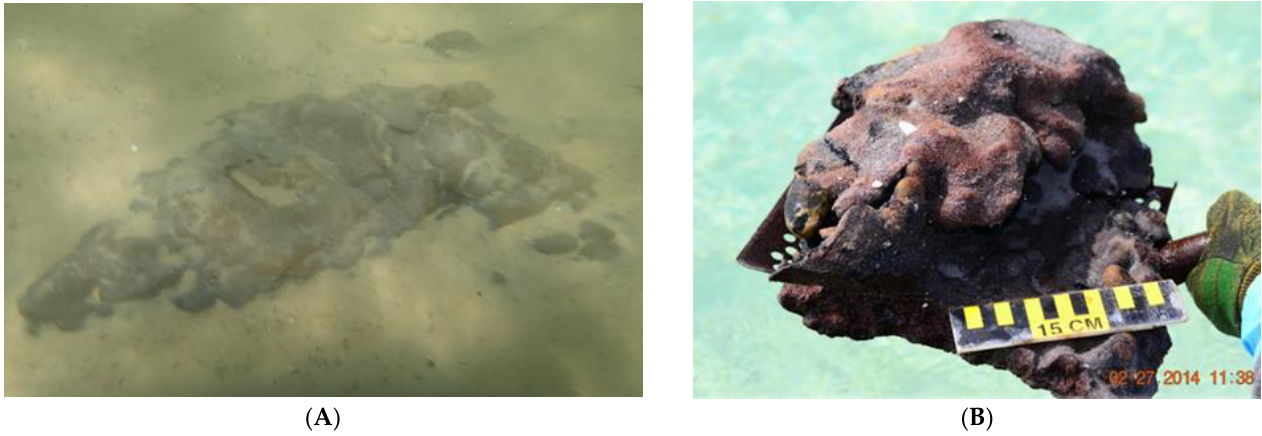
Figure 5. ( A ): Sandy SOM found in the most landward trough closest to the beach following the Deepwater Horizon oil spill. Water depth is approximately 1 m. ( B ): SOM formed as the accumulation of pieces of smaller SOMs, recovered during removal operations in 2014; it contains ~90% sand. Source: Deepwater Horizon SCAT